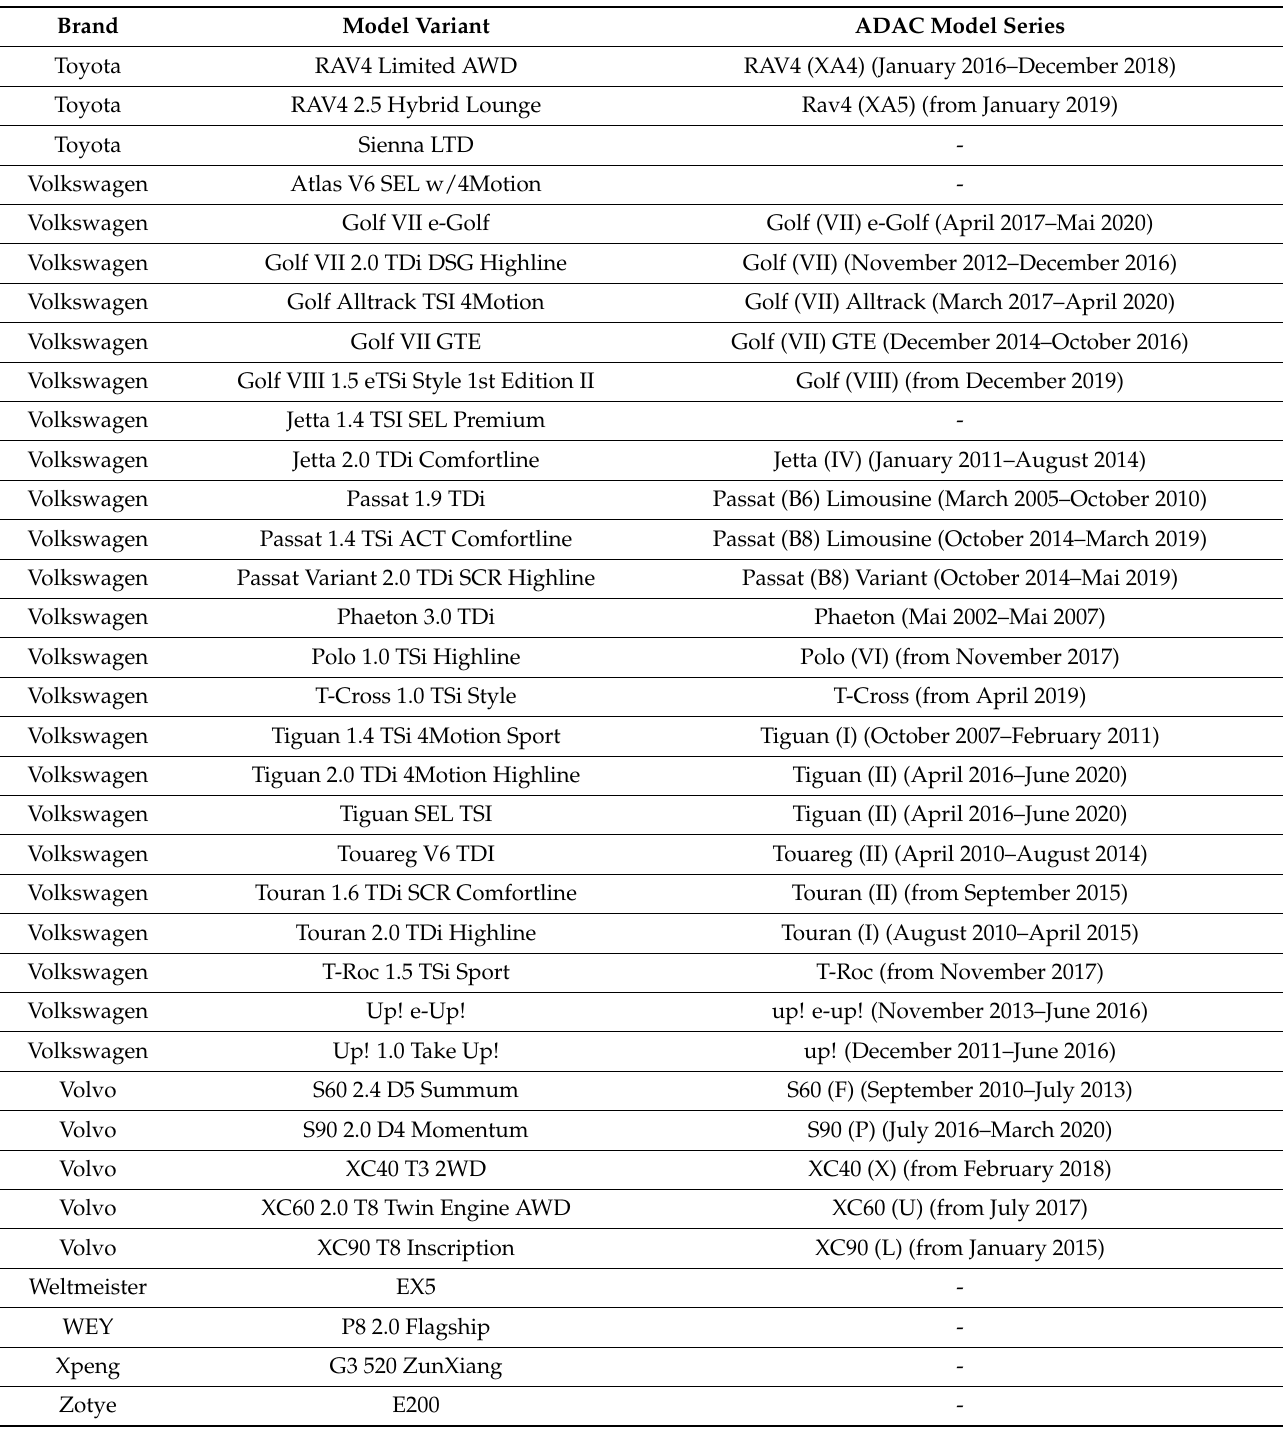
Table A15. Overview of the employed vehicles for the parametric mass model (Part